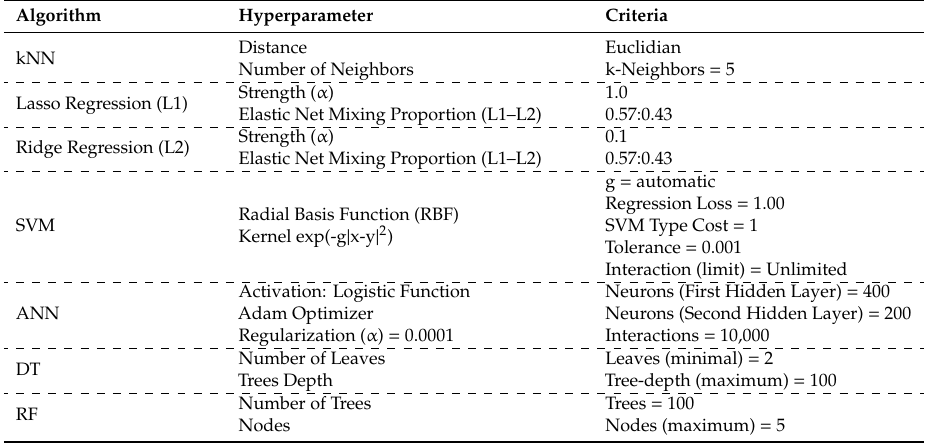
Table 1. Detailed information regarding the algorithms adopted in the proposed